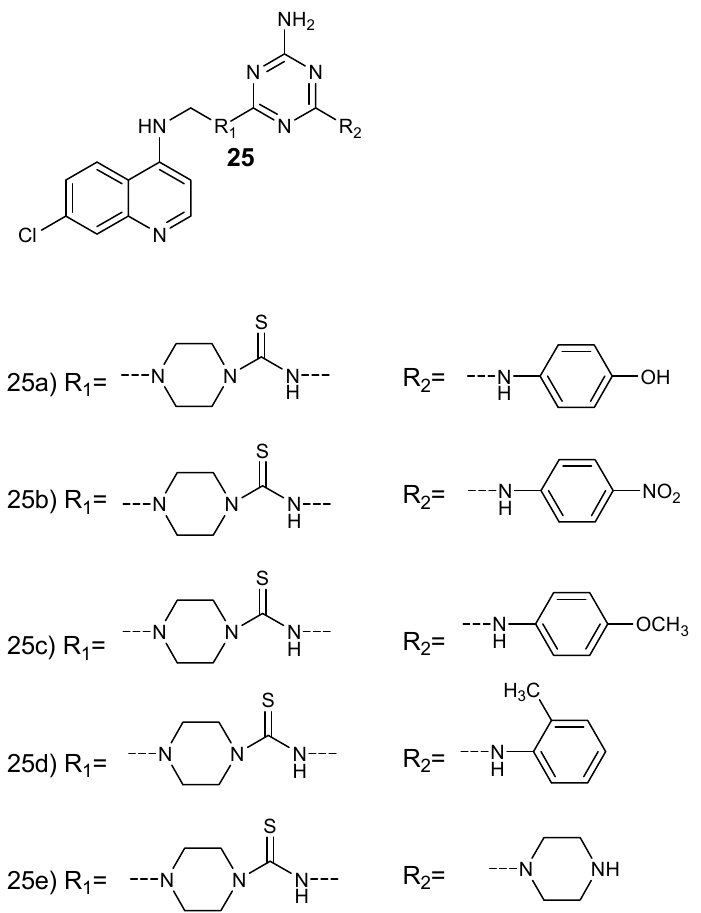
Figure 9. Structure of 4-aminoquinoline-triazine hybrid compounds 25a – e.